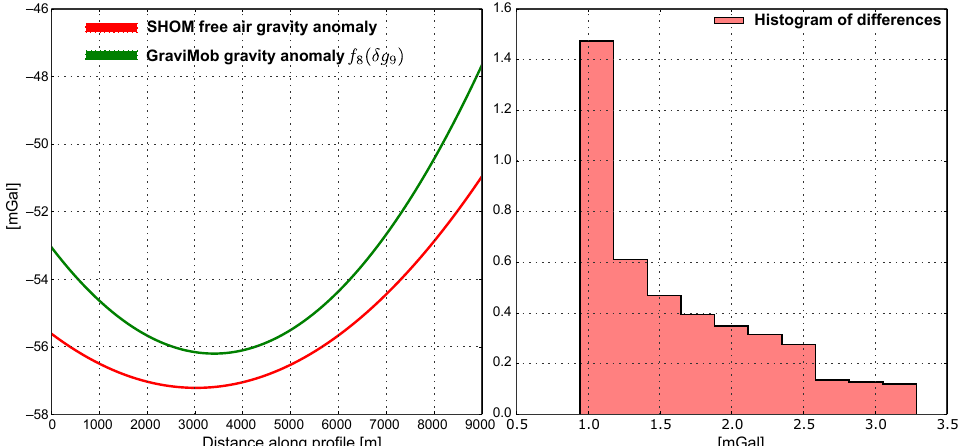
Figure 15. Left-hand plot: variations of the surface gravity anomaly deduced from that measured on route 9 ( δ g 9 ) by upward continuation using transfer function f 8 . The SHOM anomaly is represented by the red solid curve. Right-hand plot: histogram of the differences between the two anomalies at each measured point of the profile.